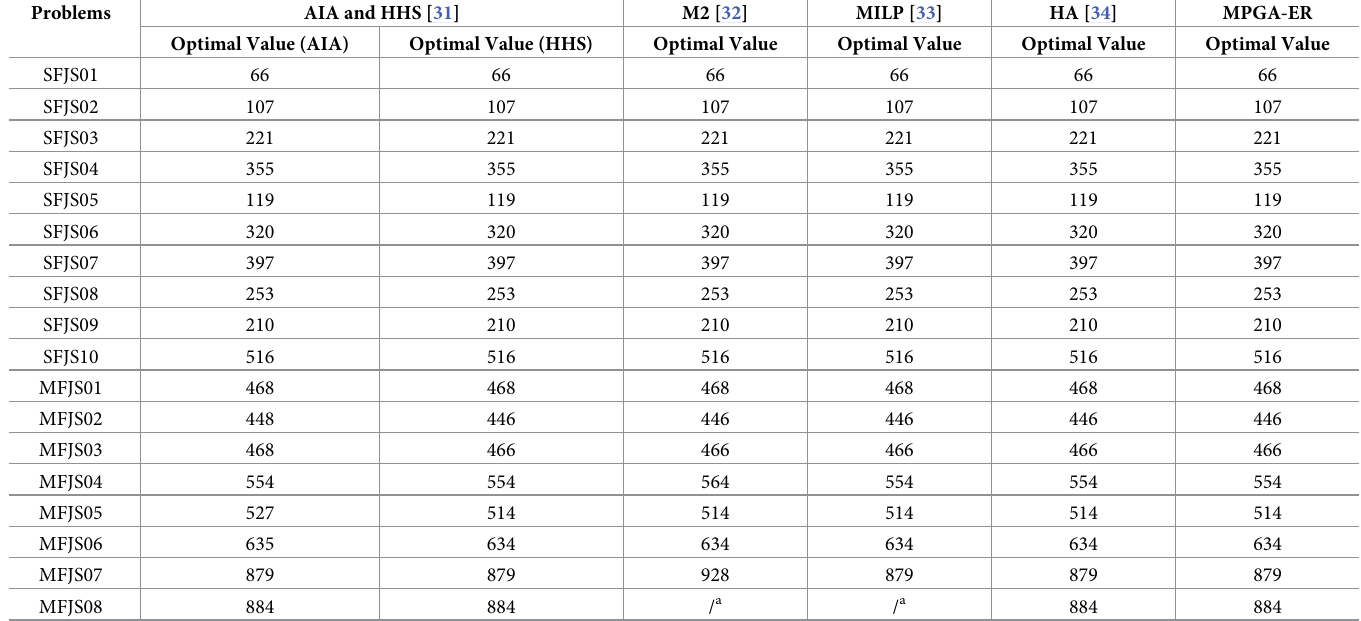
Table 6. Results of the 18 FJSP